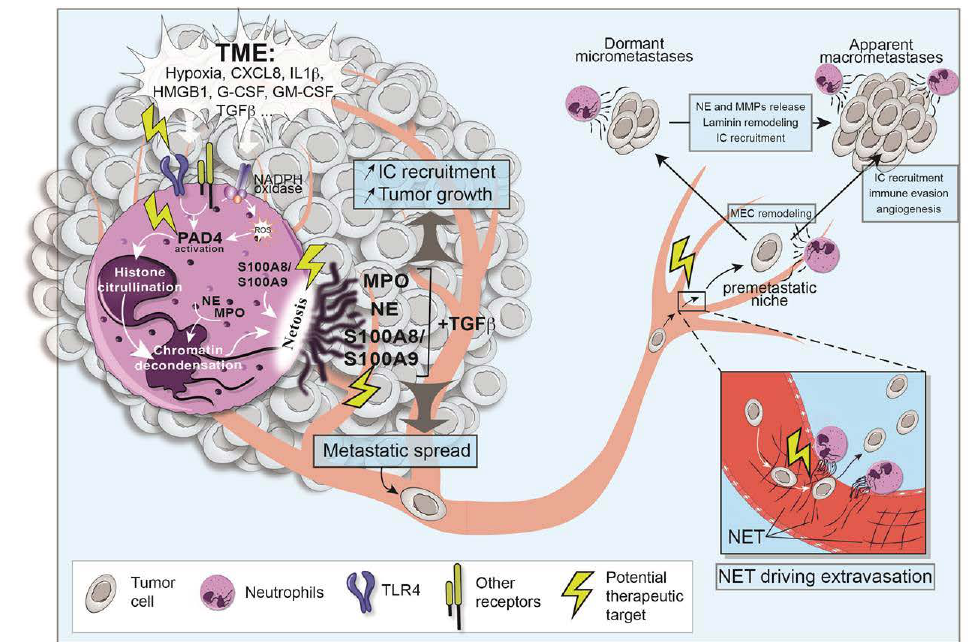
Figure 2. NETosis by TANs support metastatic dissemination and colonization at secondary sites. NET formation by TANs is favored by the tumor microenvironment (TME) and mediated by TLR4 signaling. It results in PAD4 activation, and MPO and neutrophil elastase (NE) translocation into the nucleus, which lead to chromatin decondensation and its release into the environment with cytosolic and granular proteins. The pro-tumorigenic effects of NETs occur through the action of potent proteases on matrix proteins and activation of inflammatory functions of immune cells (ICs). The adherence of NETs to the vessel wall facilitates metastatic disease progression by trapping circulating tumor cells and increases local vascular permeability. At the final stage of NETosis, a subset of molecules is released triggering an imbalance in the microenvironments and the emergence of metastatic niches. NETs can also promote cancer recurrence by activating dormant cancer cells through the remodeling of laminin and activation of integrin a3 β 1 signaling in resting cancer cells. Additionally, proteases associated with NETs can activate the complement and coagulation cascades leading to the recruitment of ICs and selectively degrade IL-6. The potential treatments that can block the NETosis process include the targeting of receptors (blockade of TLR4 or G-CSFR), PAD4 (BMS-P5 inhibitor), and DNA (inhibition of DNA de-condensation or treatment with DNase I-coated